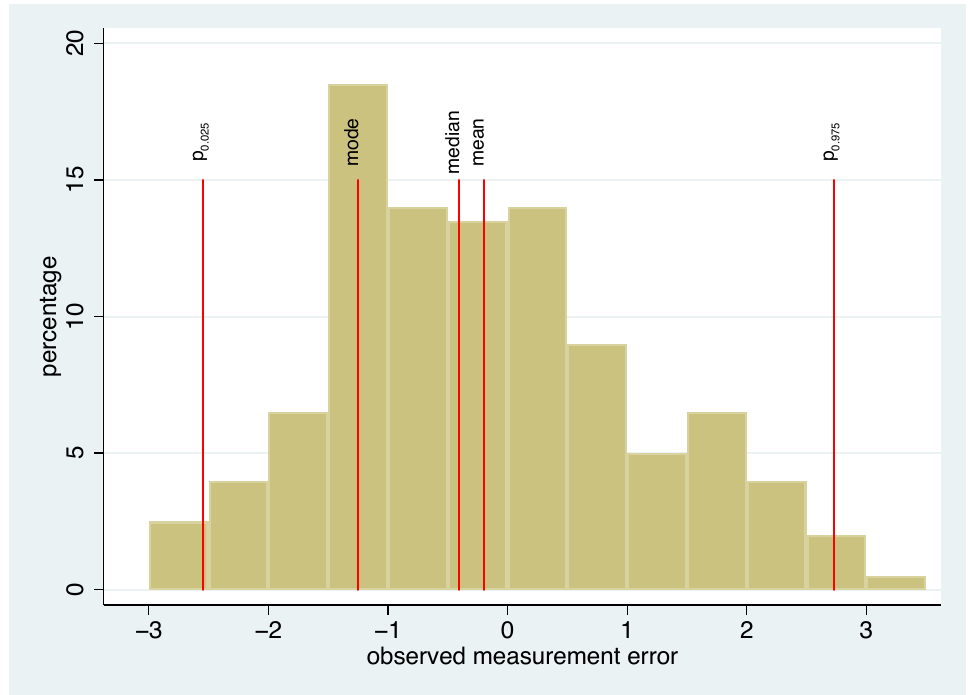
Figure 1. A histogram of the observed distribution of the measurement error in a study with gold standard measurements. The 2.5% percentile, the mode, the median, the mean, and the 97.5% percentile are marked by red